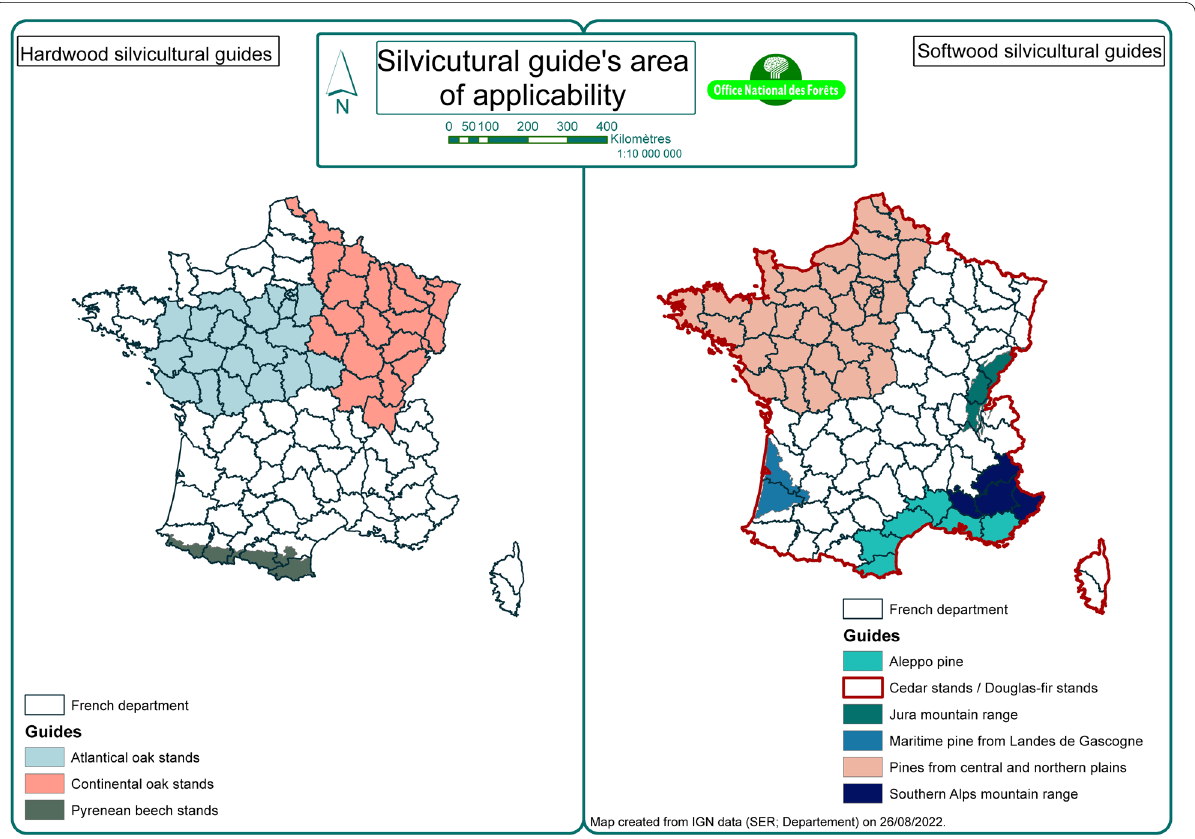
Fig. 1 Areas of applicability for each silvicultural guide represented in the